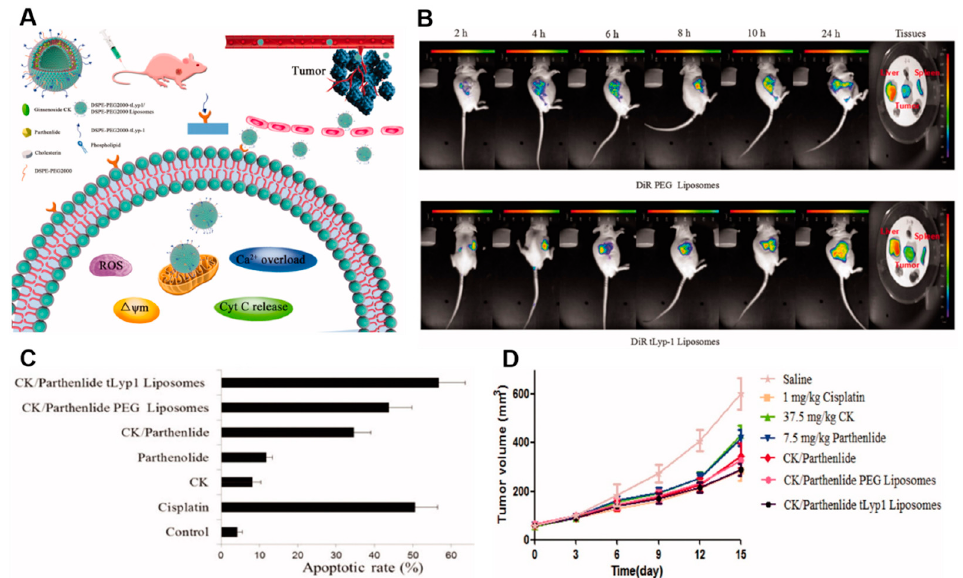
Figure 8. ( A ) Anti-tumor pathway of CK/tLyp-1 liposome. ( B ) In vivo process of CK/tLyp-1 liposome and its active targeting. ( C ) A549 treated with CK/tLyp-1 liposome shows higher apoptotic rate. ( D ) In vivo measurement of tumor volume. Reprinted with permission from Ref. [126]. 2018, Taylor & Francis Online.